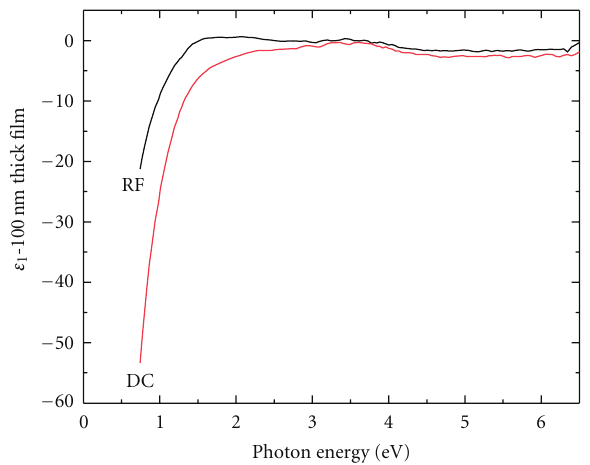
Figure 10: Relaxation time τ for free electrons in Mo as a function of the bulk layer thickness for both dc and rf mode sputtering. Also shown are the results of fits using a simple conical grain growth